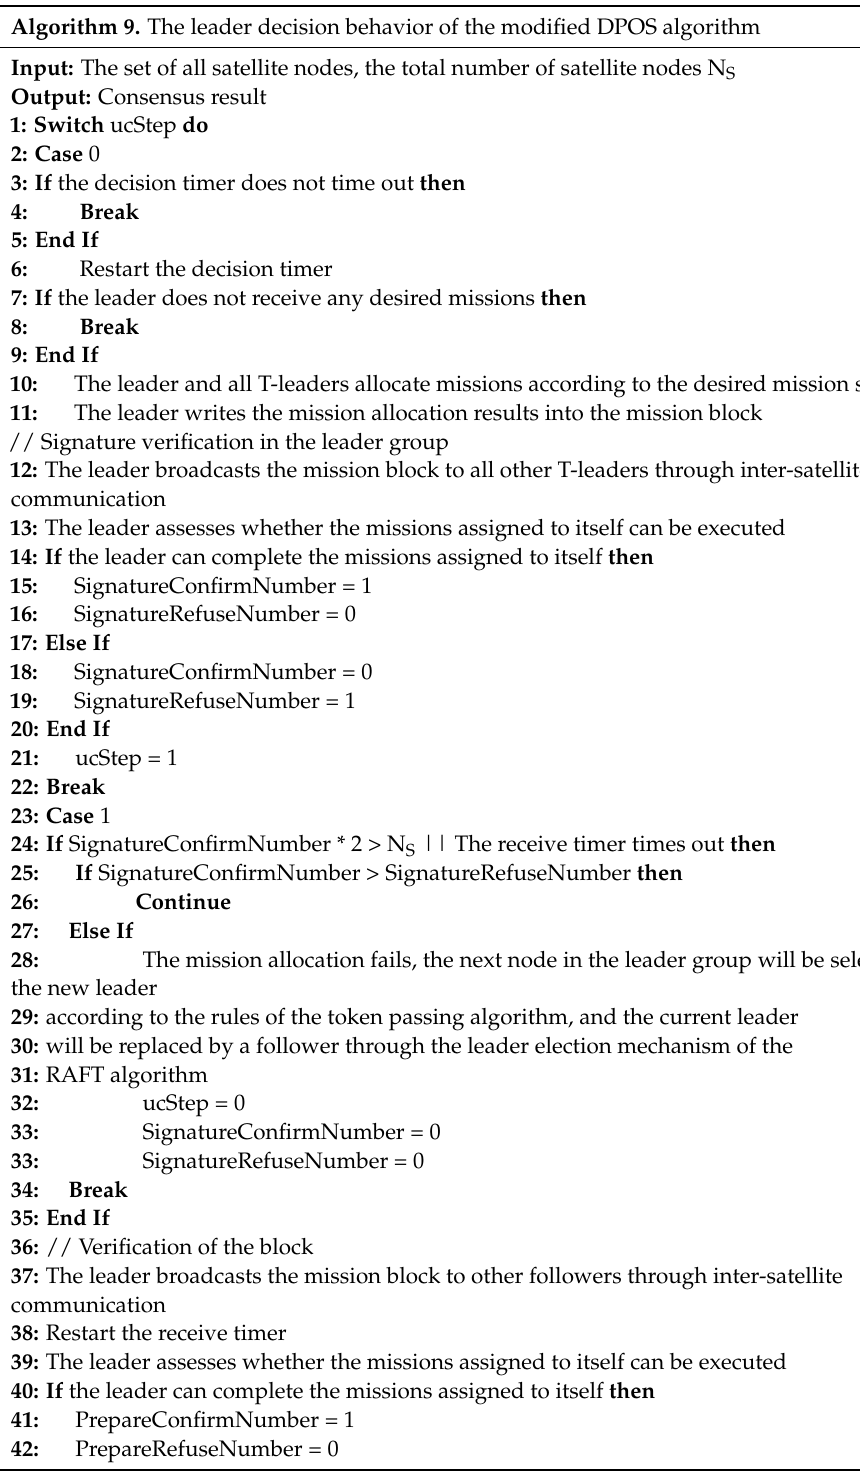
Algorithm 9. The leader decision behavior of the modified DPOS